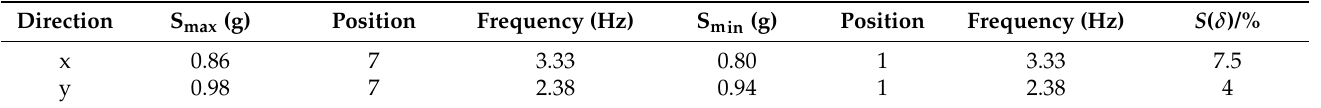
Table 7. Acceleration floor response spectrum at different positions of the raft foundation (2–10